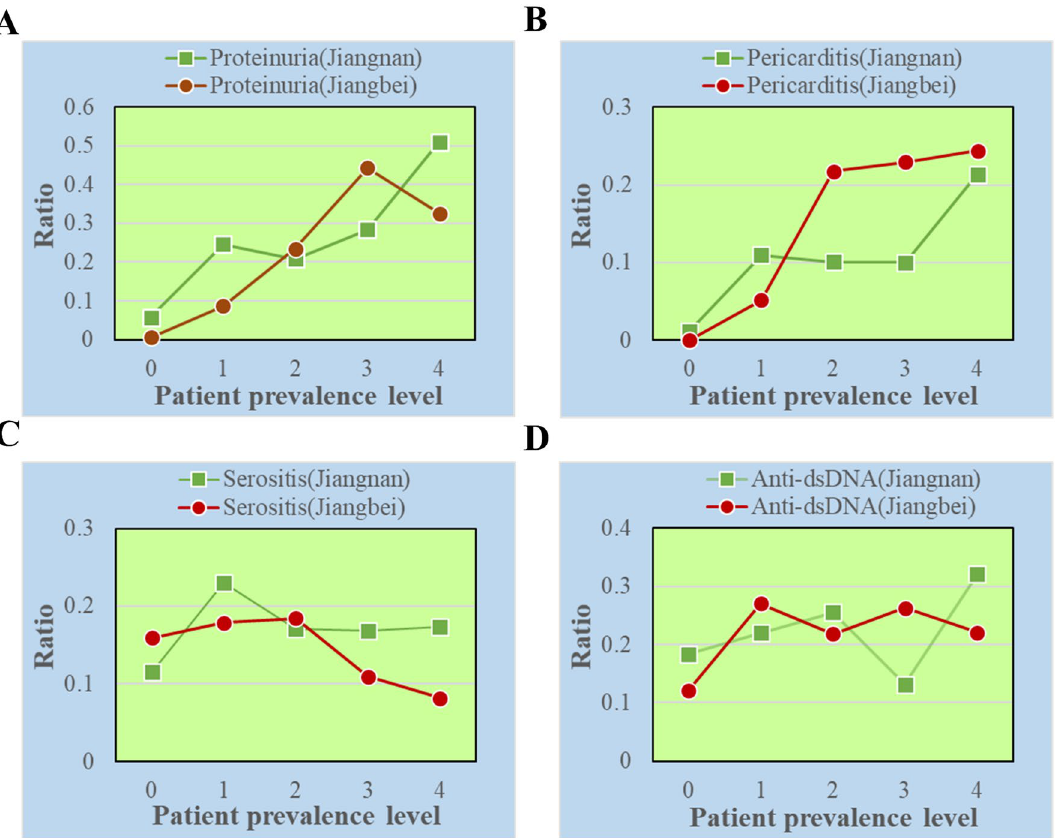
Figure 4. Proportion of clinical manifestation indicators of h-SLE patients with 5 prevalence levels in Jiangnan and Jiangbei. ( A ) Proteinuria. ( B ) Pericarditis. ( C ) Serositis. ( D ) Anti-dsDNA antibodies. The patient prevalence (cases per 100,000 people) was divided into 5 levels: level 0: prevalence < 2 (432 cases); level 1: 2 < prevalence < 3(443 cases); level 2: 3 < prevalence < 5(496 cases); level 3: 5 < prevalence < 10(503 cases); level 4: prevalence > 10(357